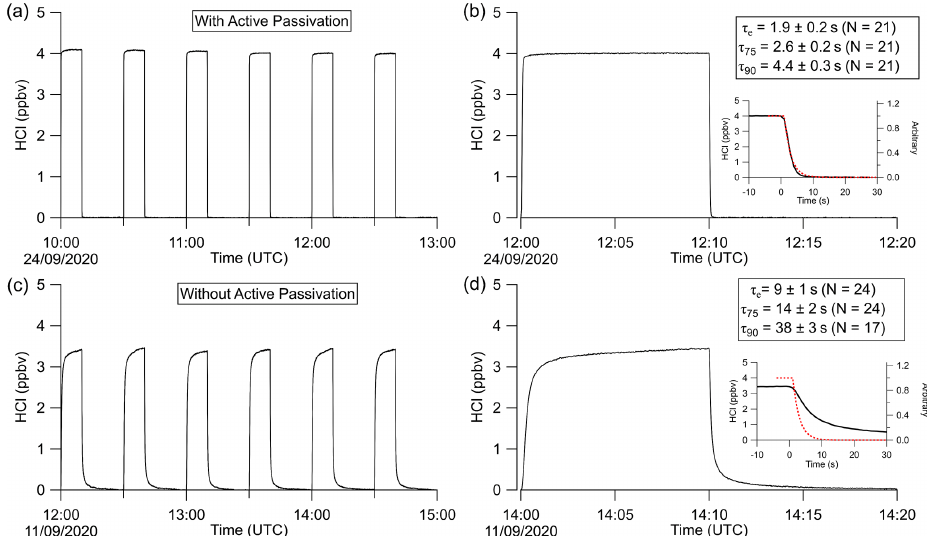
Figure 5. Excerpted time series of HCl permeation source additions with (a, b) and without (c, d) use of active passivation. (a) TILDAS response to HCl permeation source addition to the sample line for 10min every 30min. (b) Example case from panel (a) demonstrating the profile of the decay timescales. Reported τ (cid:48) s values represent the mean and standard deviation of the entirety of these experiments. Inset shows a close-up of the actual decay compared with the dashed red line, representing the theoretical decay profile of a non-sticky compound modeled on the residence time of air in the absorption cell. Panels (c) and (d) are analogous to (a) and (b) but without use of active passivation.